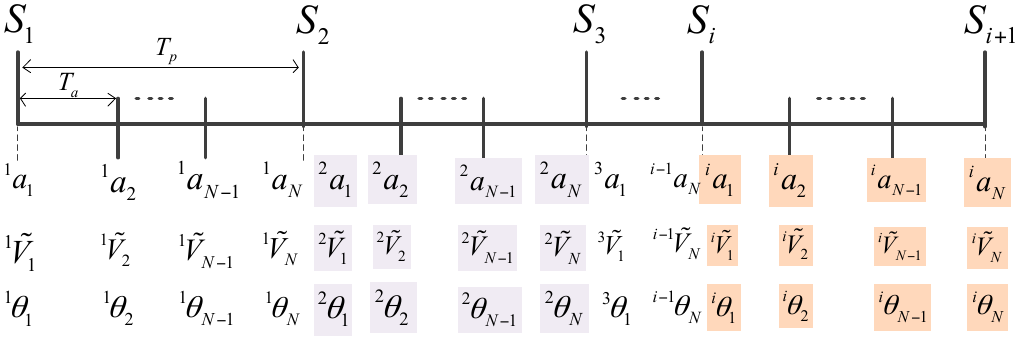
Figure 6. The sketch map of data update.